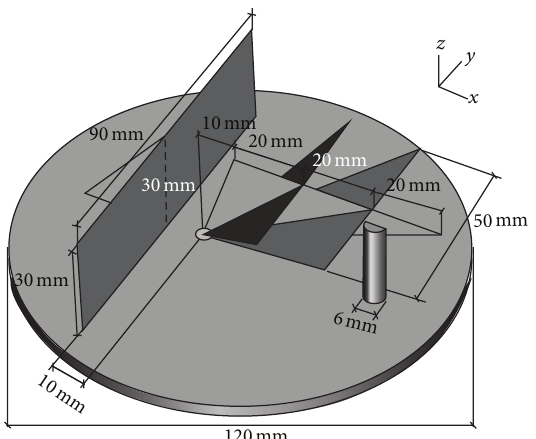
Figure 22: Proposed planar directional UWB antenna for a lower cutoff frequency of 2 GHz.